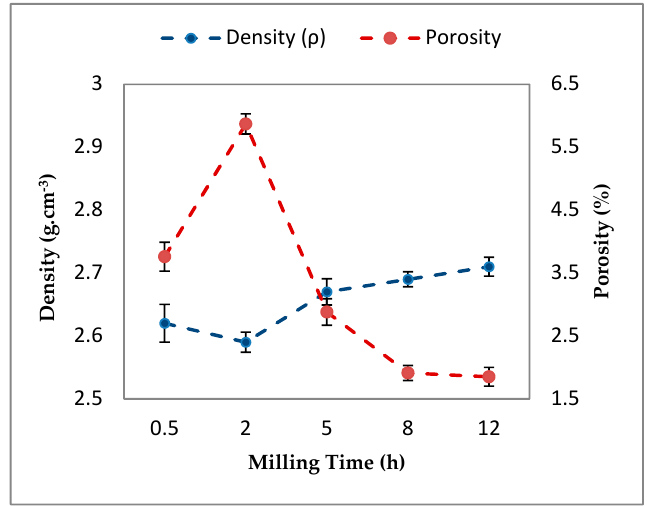
Figure 6. Variation of density and porosity of milled Al-5Al 2 O 3 as a function of milling time. As a matter of fact, the sintered density is dependent on the morphology of the powders after milling, size, and distribution of the nano-reinforcement within the matrix, as well as compaction and sintering parameters [24]. Lower density at early stages of milling is due to the presence of aluminum agglomeration and Al 2 O 3 clusters in the microstructure. Agglomeration and clustering of Al 2 O 3 nanoparticles act as barriers that slow down the diffusion process which is needed for the sintering process. The increment of density is attributed to the better dispersion of Al 2 O 3 nanoparticles within the matrix at longer milling times. At longer milling times, Al 2 O 3 nanoparticles are dispersed homogeneously (Figure 2d,e), which accelerates the diffusion rate during sintering, as reported by [25].